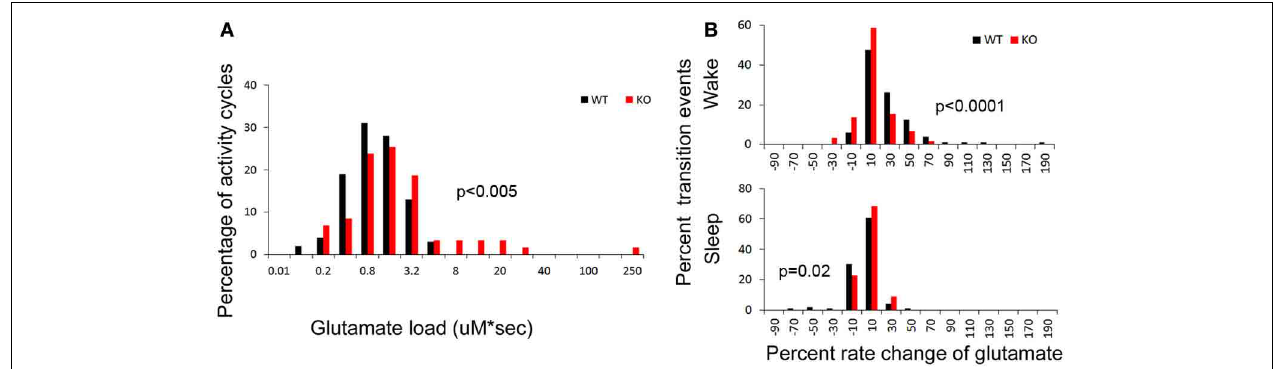
FIGURE 5 | (A) Group data for glutamate loads calculated per wake cycle in drift corrected traces of glutamate in-vivo recordings (see Methods). Frequency histogram represents glutamate loads per wake (activity) cycle for every mouse in study and show significantly higher number of activity cycles with larger glutamate loads in KO mice compared to WT (red distribution curve shifts to the right, p < 0 . 03). ( B) Frequency